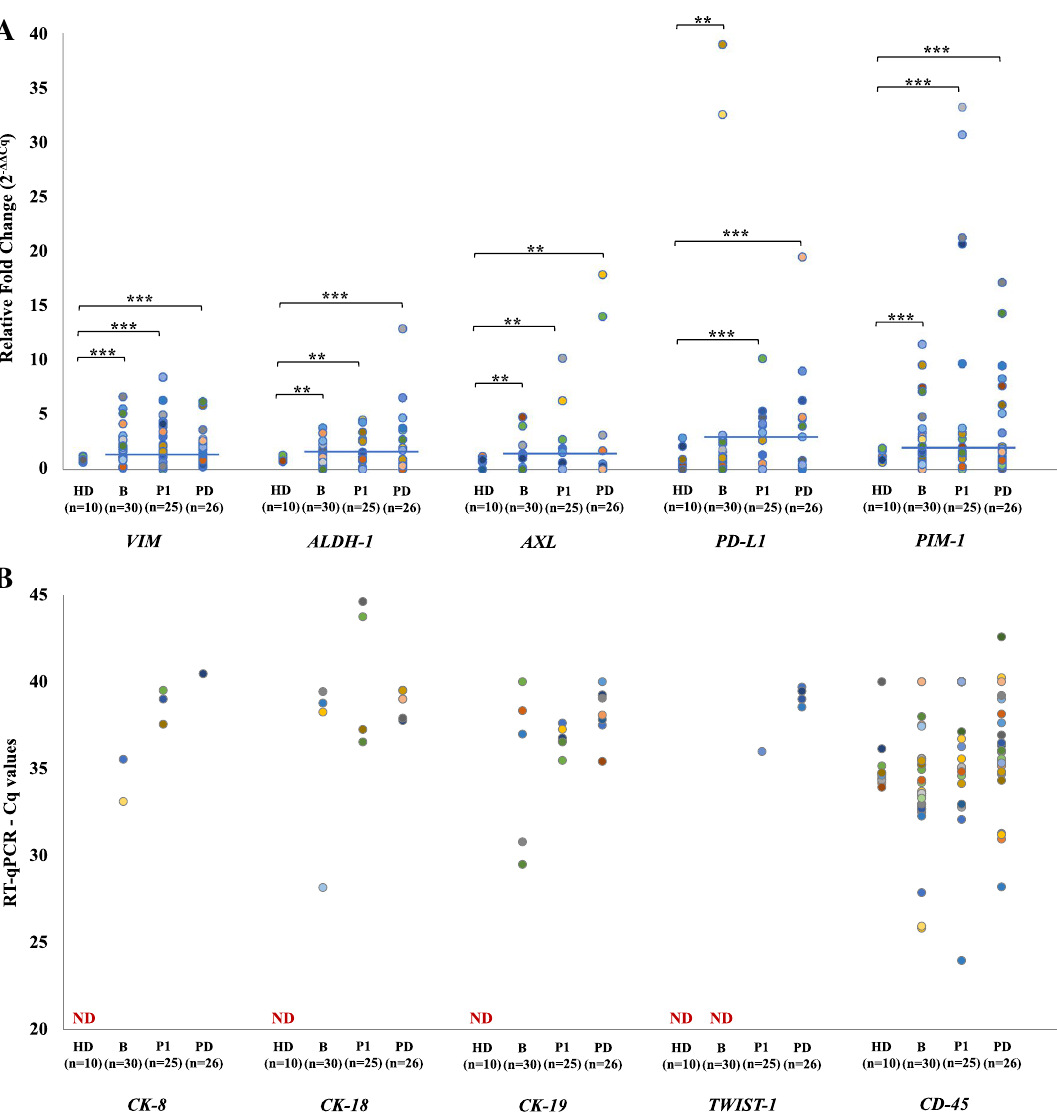
Figure 2. Gene expression levels for size-based CTC-enriched fractions for NSCLC patient samples at baseline (n = 30), at post-1st cycle (n = 25) and at PD (n = 26) and for HD ( n = 10): ( A ) relative fold change values (2 –ΔΔCq